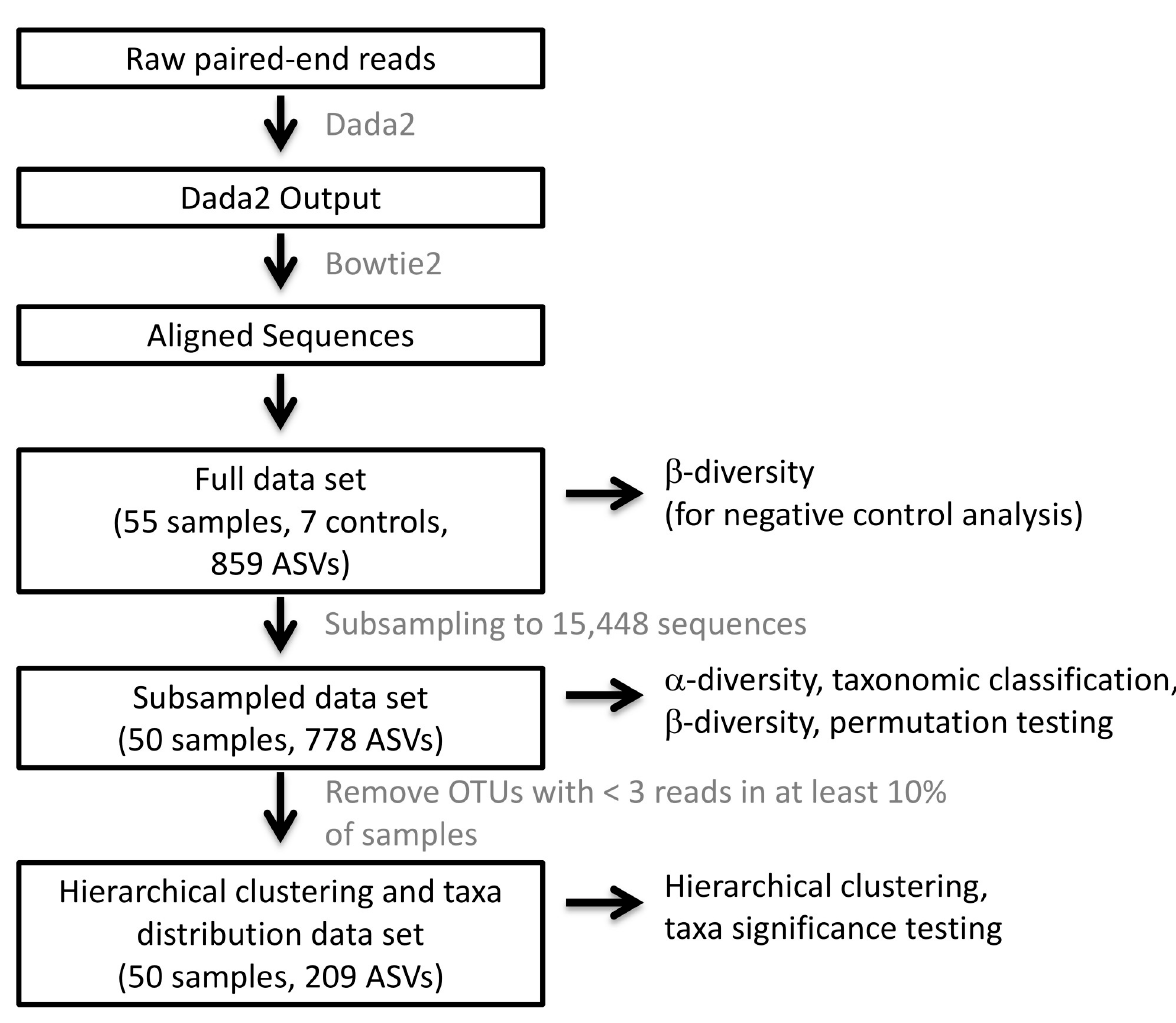
Fig 1. Data processing flow chart. DNA sequences were processed into data sets using the software tools and procedures as described in the text and illustrated here as a pipeline. Boxed black text indicates significant steps in the pipeline or data sets produced for specific analyses. Gray text specifies the software tools or procedures used in the pipeline. Unboxed black text specifies the analyses performed on the indicated data sets.